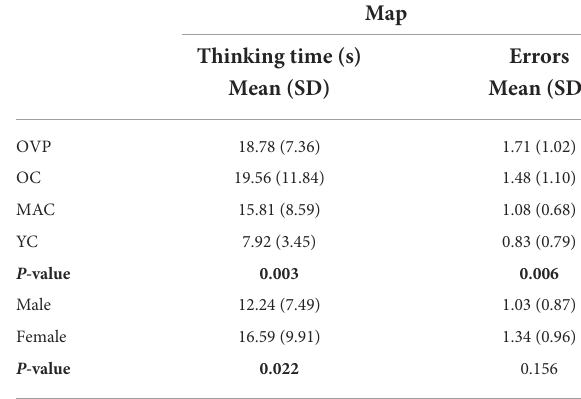
TABLE 4 Comparison of 3D driving test indexes between